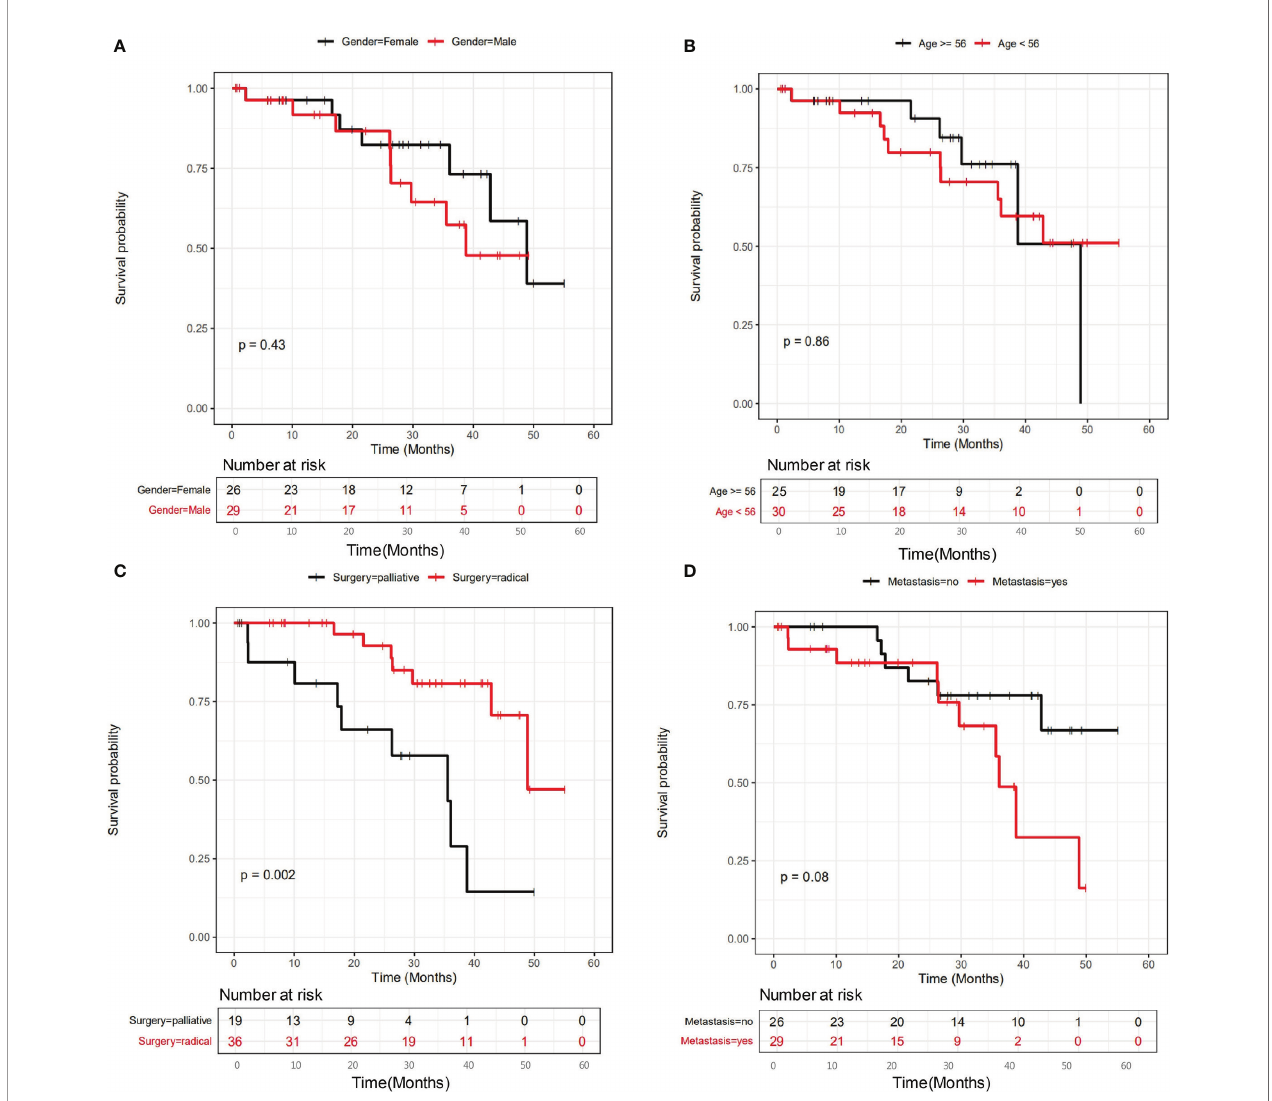
FIGURE 2 | The in fl uence of clinicopathological factors on the prognosis of all patients involved in this study. The in fl uence of gender, age, surgery types and metastasis were shown in panel (A – D) ,